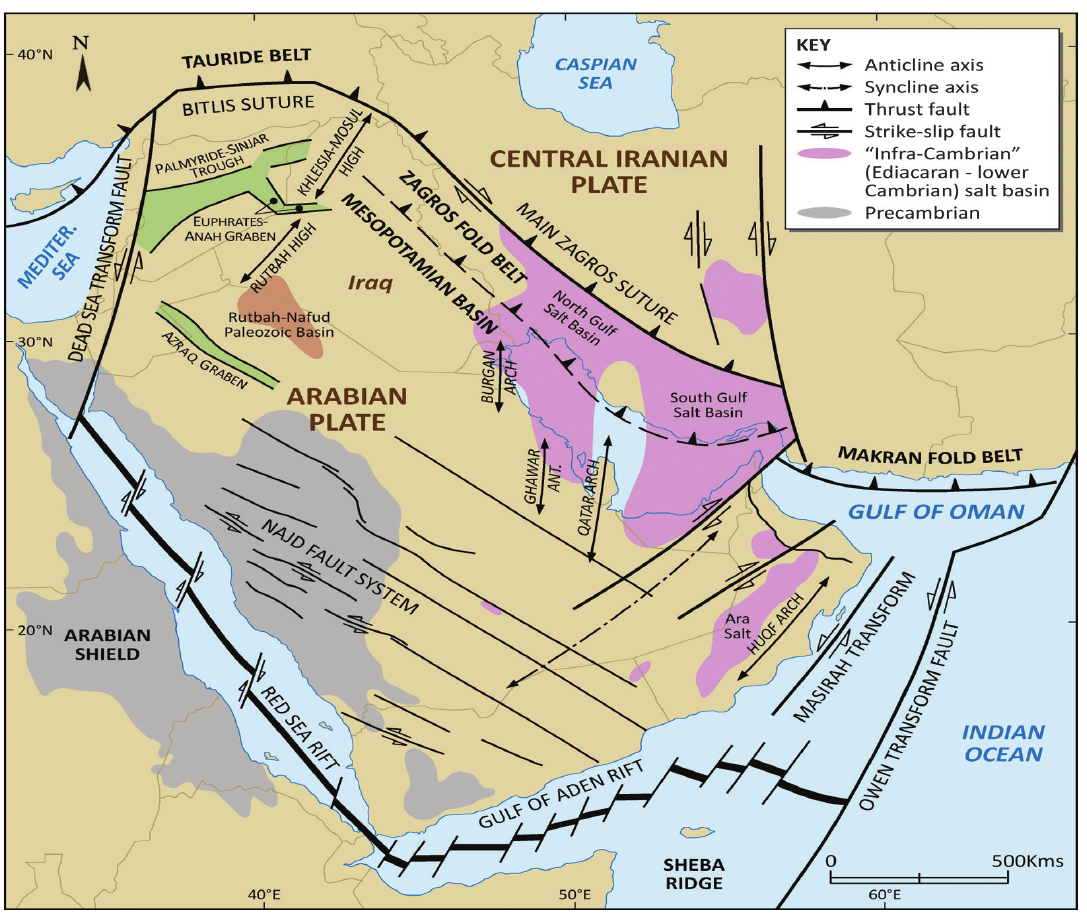
Figure 1. General map illustrating the Zagros fold-thrust belt (ZFTB) within the Kurdistan region of Iraq (after Reference